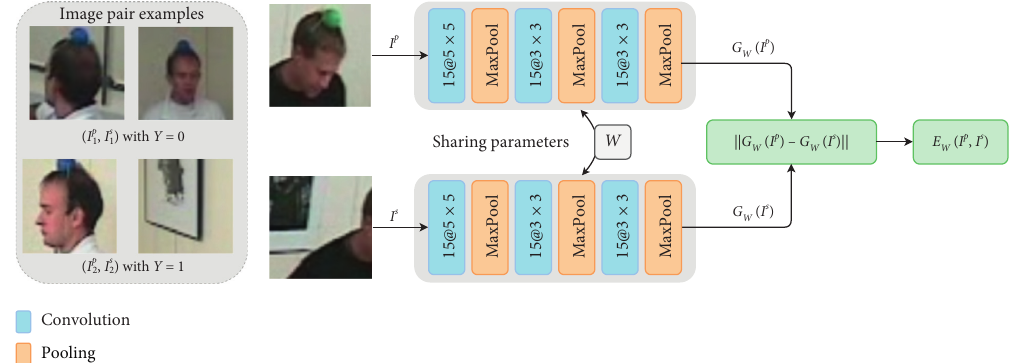
Figure 2: Framework of the adopted Siamese network with image pair